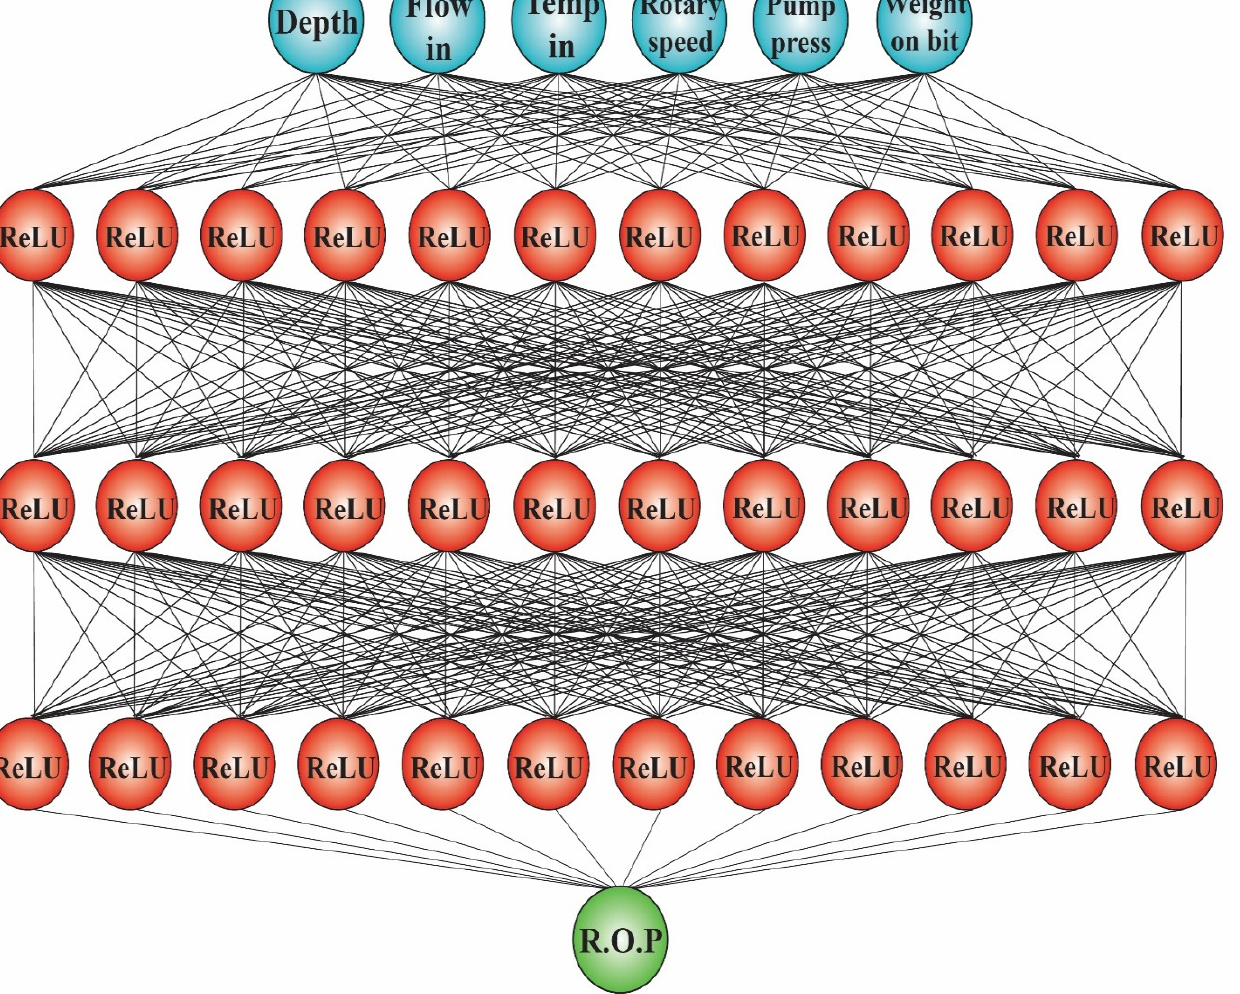
Figure 16. Architecture of the optimized neural network. The optimized neural network has a mean absolute error of 3.98 and an R 2 score of 0.73. When compared to the standard deviation of the ROP, the mean absolute error represents 19%. Based on the R 2 score, our optimized neural network explained 73% of the ROP variance (Figure 17). It is still an acceptable result, but not as good as the results using the random forest regressor.